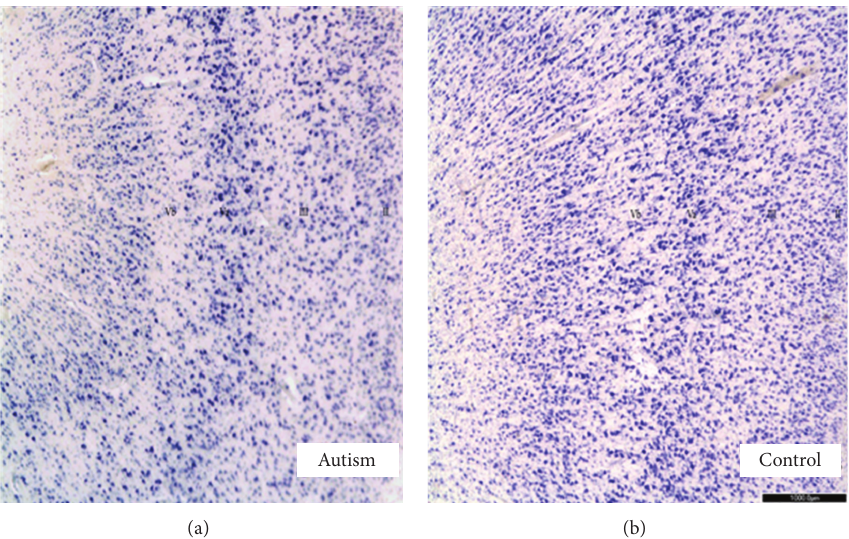
F 6: Lamination of ACC in control and autism brains (40x). Note irregular lamination obvious in layers III-V in an autism case (le �gure) compared to control at right. In each �gure, layer II is on right side, layers V-Vi at le. Also note, the ACC lacks a layer IV. Permissions granted for modi�ed �gure from Simms et al., 2009 [81]. Scale bar =